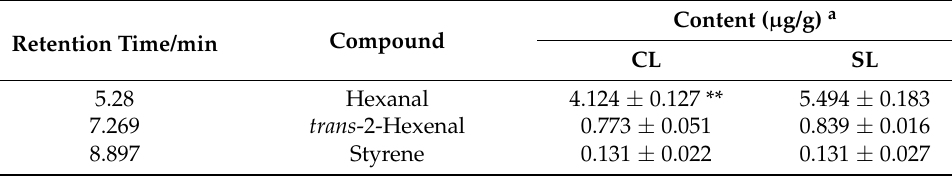
Table 1. Content of volatile components in oolong